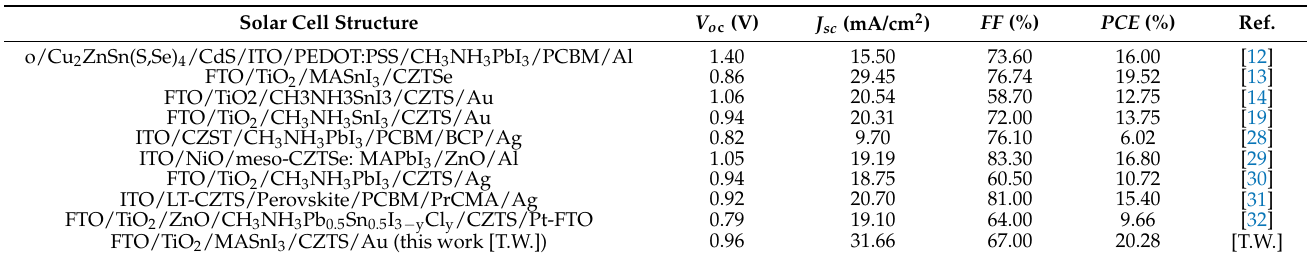
Table 1. Parameters V oc , J sc , FF and PCE reported in solar cells using SCAPS-1D simulation and experimental results. Solar Cell Structure